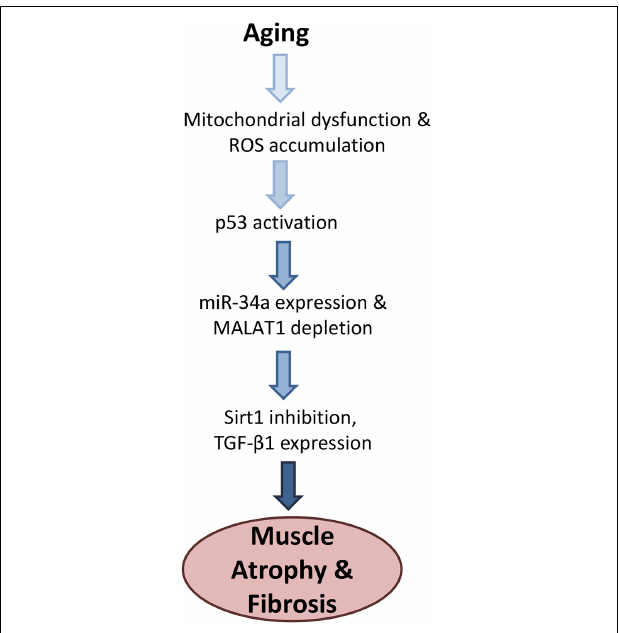
FIGURE 3 | Proposed model for age-related changes linking oxidative stress with increased miR-34a-5p expression and Malat1 inhibition. Activation of p53 both stimulates miR-34a and suppresses MALAT1, which creates a feed-forward cycle further increasing miR-34a levels. Elevated mir-34a targets Sirt1 which can increase senescence as well as TGF- β 1, increases fibrosis. Together these factors are likely to impair muscle function with